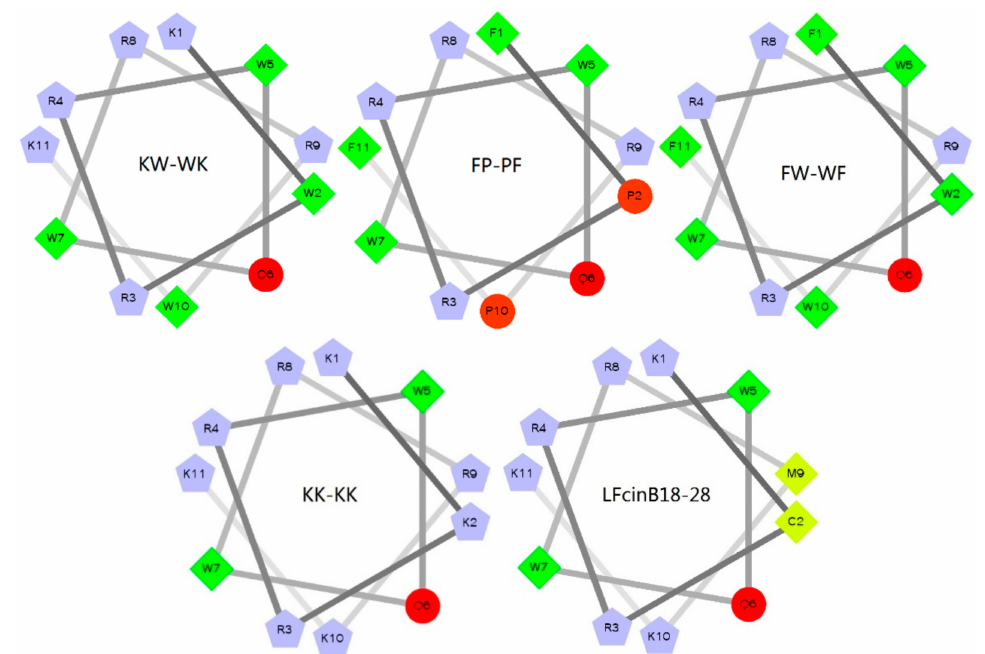
Figure 1. Helical wheel projections of the peptides. By default the output presents the hydrophilic residues as circles, hydrophobic residues as diamonds, and potentially positively charged as pentagons. Hydrophobicity is color-coded as well: the most hydrophobic residue is green, and the amount of green decreases proportionally to the hydrophobicity, with zero hydrophobicity coded as yellow. Hydrophilic residues are coded red, with pure red being the most hydrophilic (uncharged) residue and the amount of red decreasing proportionally to the